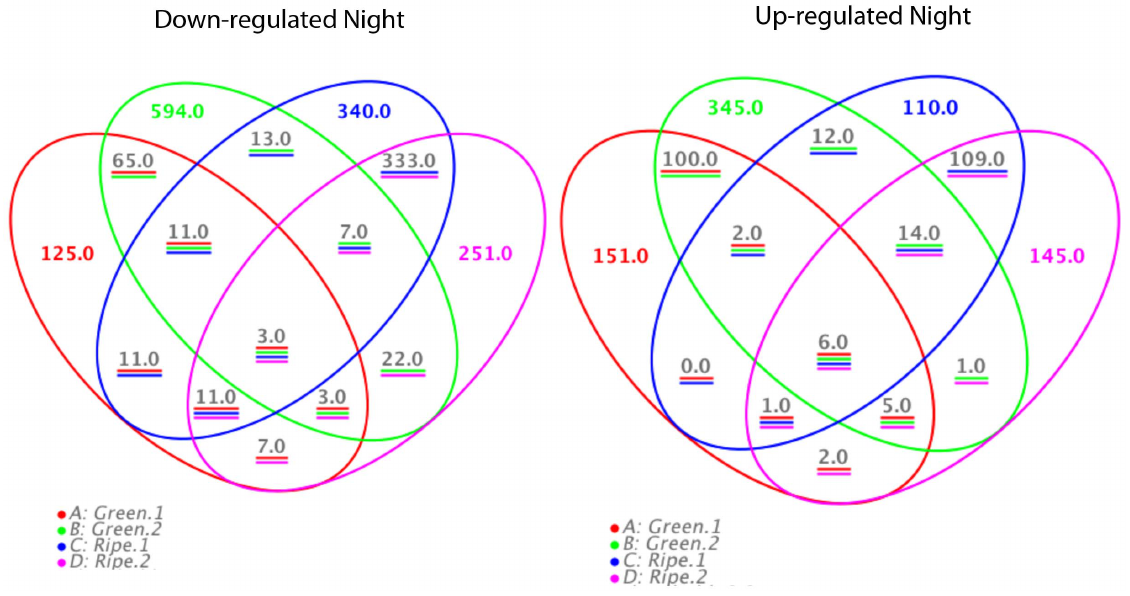
Figure 5. Overview of day/night modulated transcripts (fold change . 2; pval adj , 0.05) in each developmental stage. Left diagram night down-regulated transcripts; Right diagram night up-regulated transcripts.